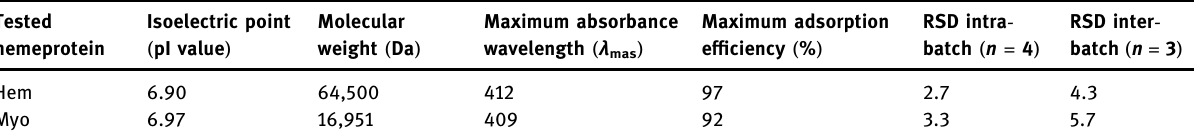
Table 2: Extraction e ffi ciency of proteins and RSDs of extraction e ffi ciencies showing reproducibility of the AgStNP – methacrylate polymeric monolith